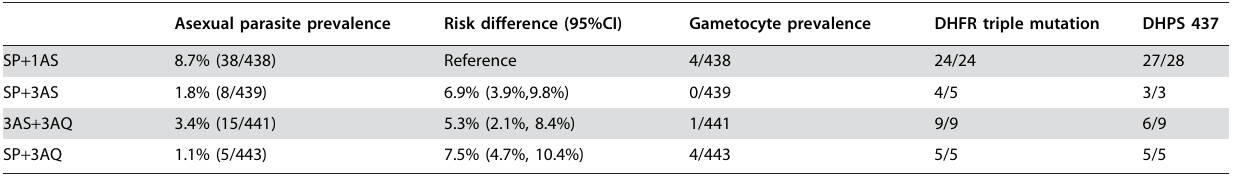
Table 3. The prevalence of parasitaemia, and proportion of parasitaemic children carrying parasites positive for DHFR and DHPS mutations associated with resistance to pyrimethamnine and suphadoxine in December, after administration of IPT during